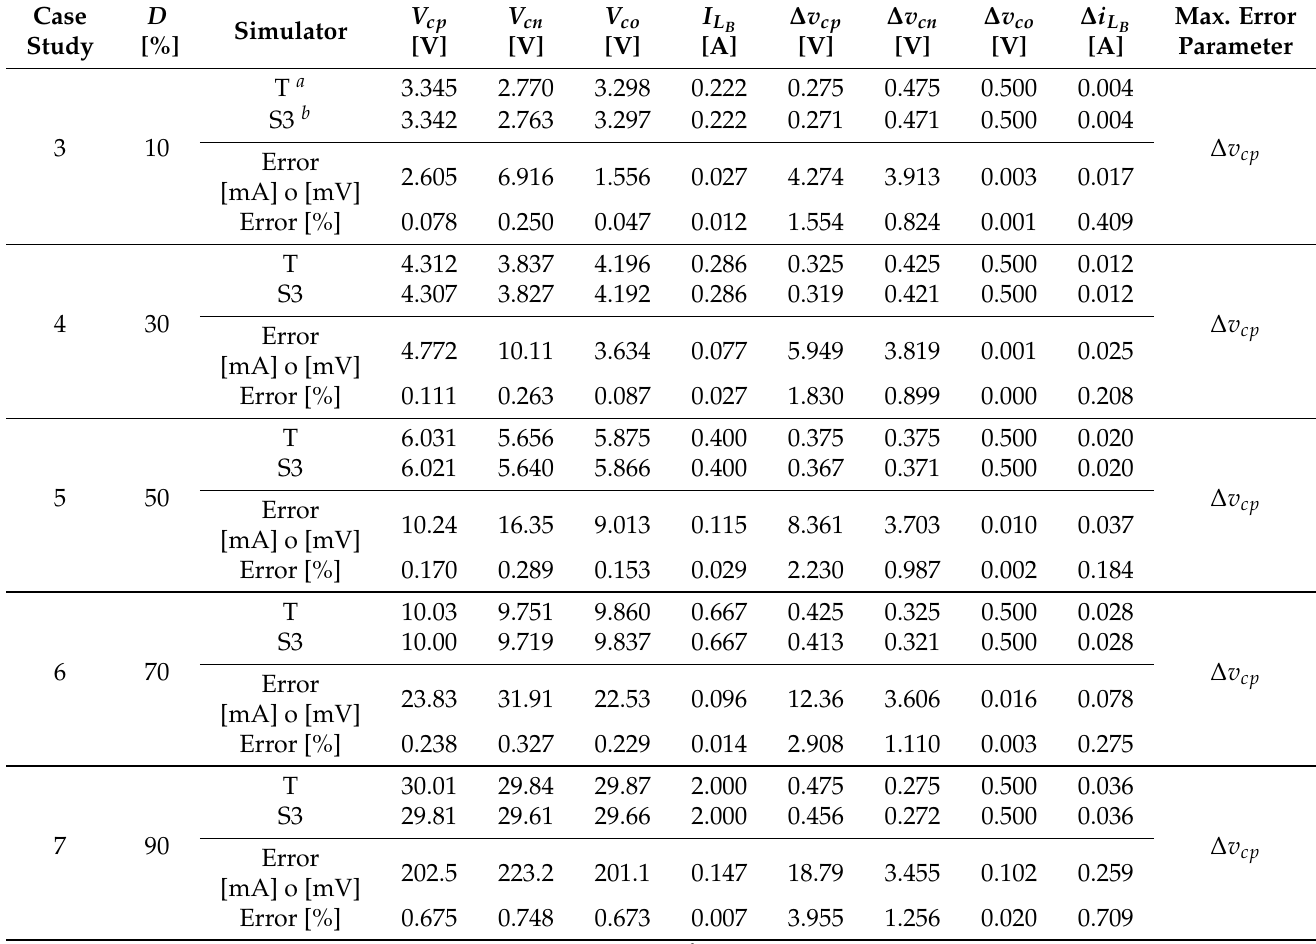
Table 5. Theoretical and simulated values of the converter with Duty cycle variation.